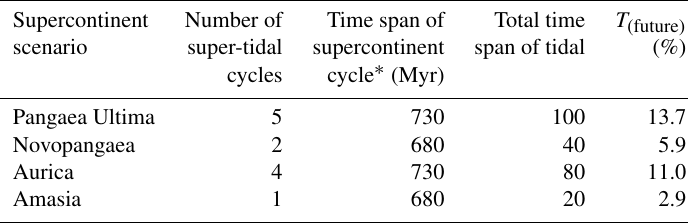
Table 2. Summary of the total time each scenario was in a super-tidal state. Supercontinent Number of Time span of Total